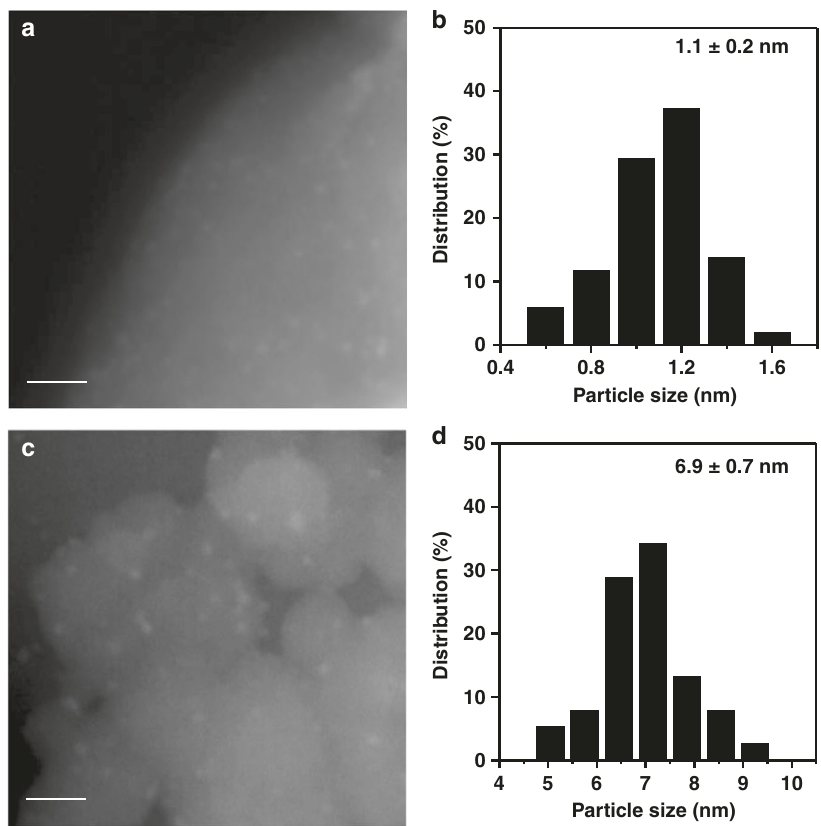
Fig. 5 Structural characterization of Pt – NCs/N – C and Pt – NPs/N – C. a STEM image of Pt – NCs/N – C. Scale bar, 10 nm. b Particle size distribution of Pt – NCs/ N – C. c STEM image of Pt – NPs/N – C. Scale bar, 50 nm. d Particle size distribution of Pt – NPs/N –